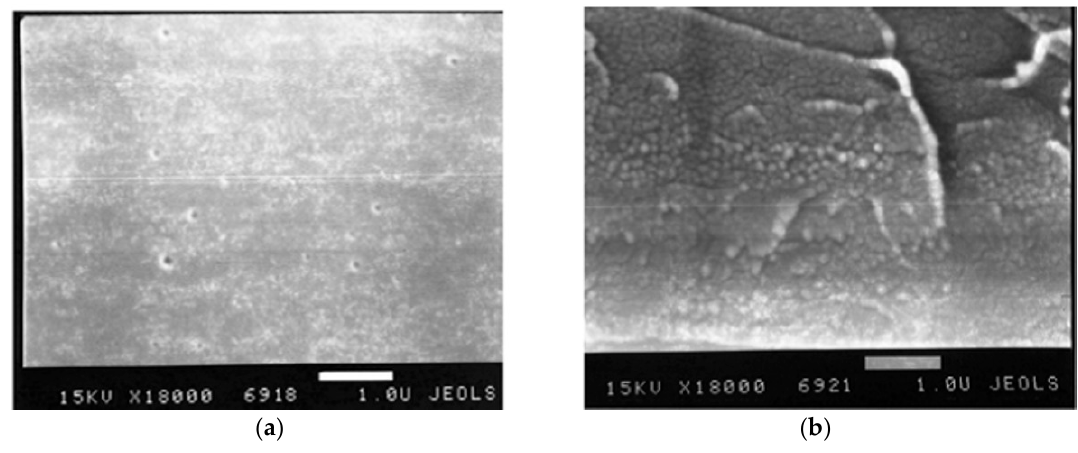
Figure 24. The composite PAI-2-SNT-II: SEM of ( a ) Upper; ( b ) Button surfaces [121].